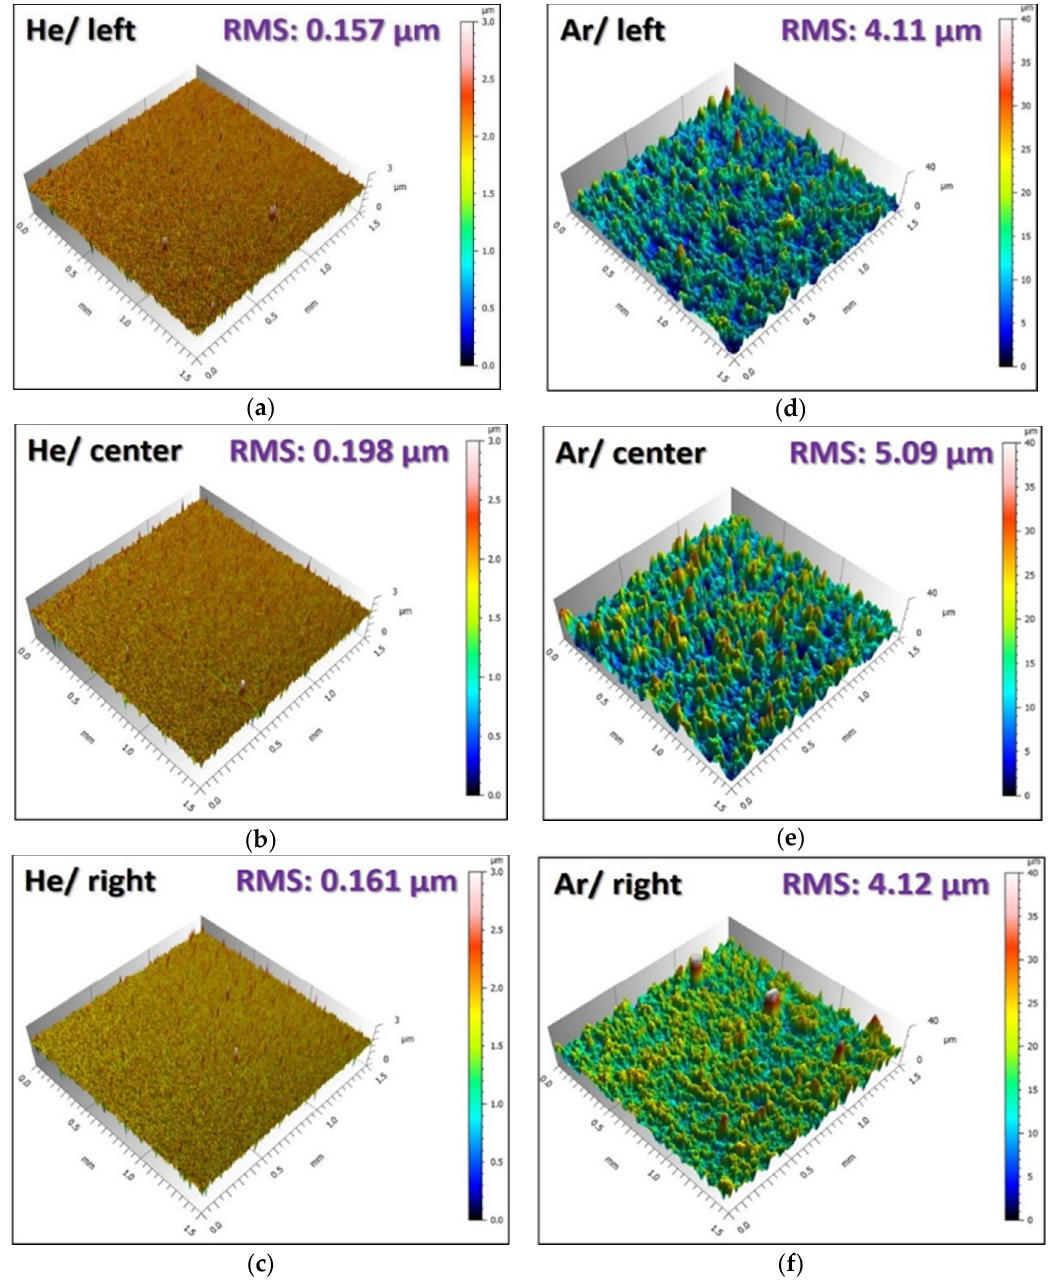
Figure 4. Profiler surface analyses (RMS and 3D views)-W plates in Hollow-Cathode discharge: ( a ) the left-side point of the W sample exposed to He plasma; ( b ) the center point of the W sample exposed to He plasma; ( c ) right-side point of the W sample exposed to He plasma; ( d ) the left-side point of the W sample exposed to Ar plasma; ( e ) the center point of the W sample exposed to Ar plasma; ( f ) right-side point of the W sample exposed to Ar plasma.